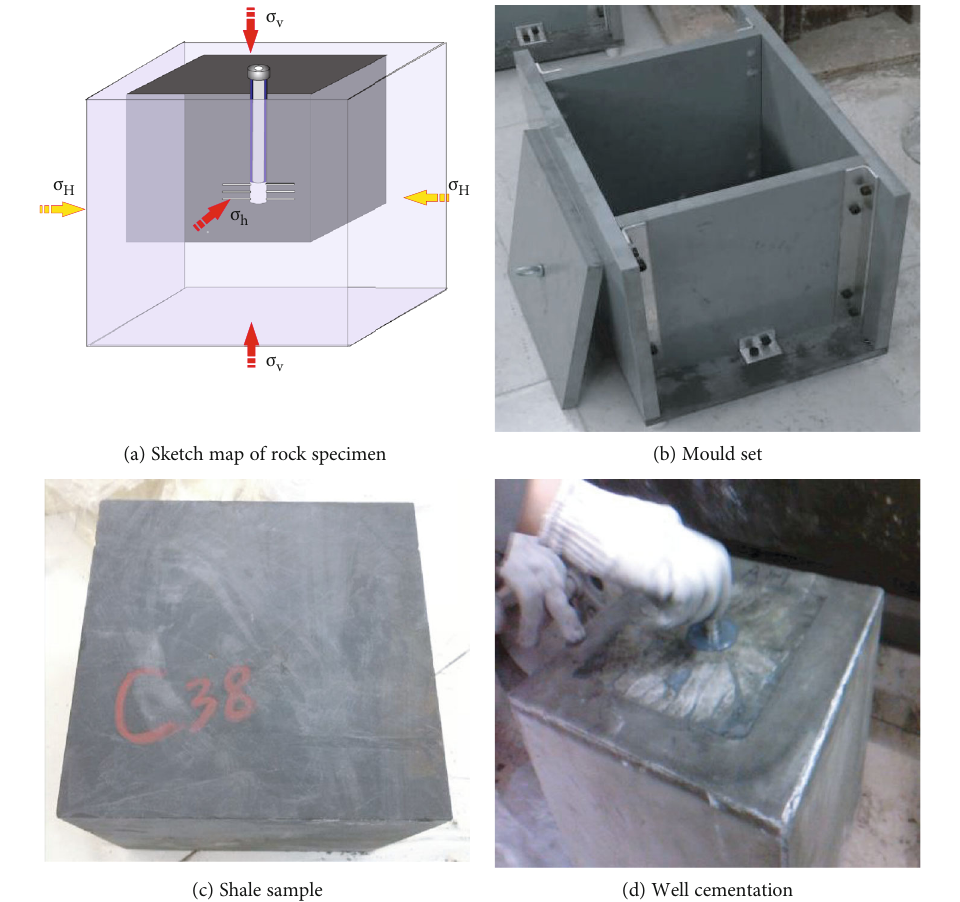
Figure 2: Schematic of the rock specimen preparation.